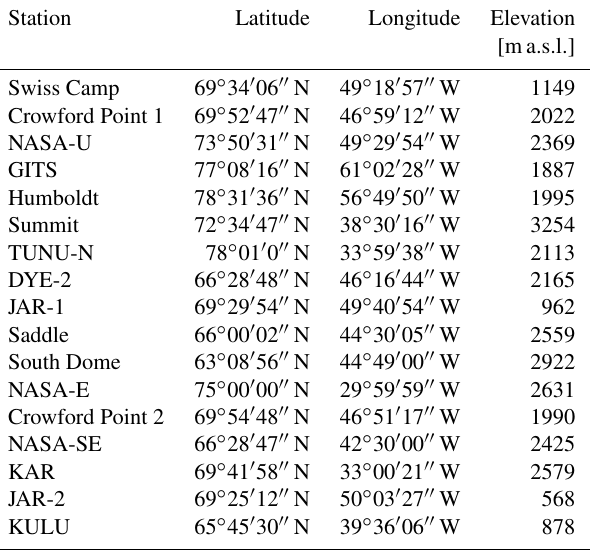
Table 2. Locations of the automatic weather stations of the Green- land Climate Network (GC-Net) sites used to validate the results in this study.